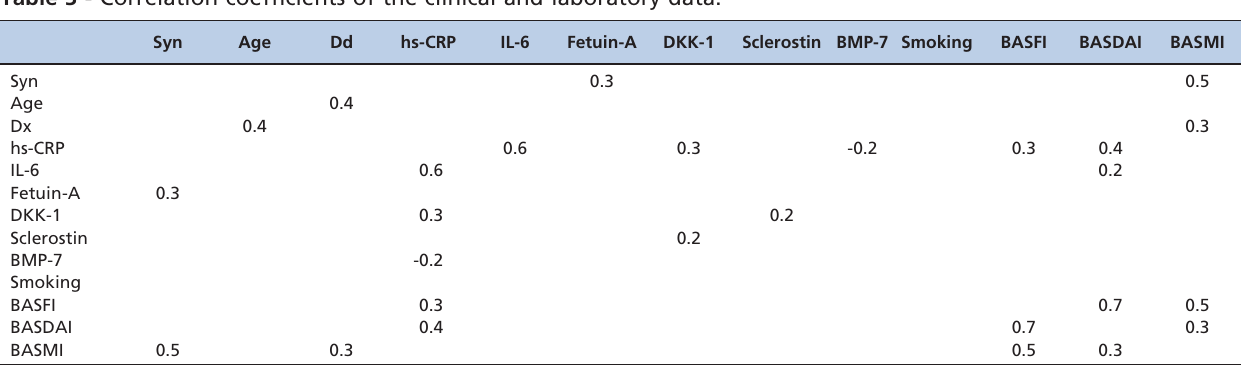
spondylitis functional index, BASDAI: Bath ankylosing spondylitis disease activity index and BASMI: Bath ankylosing spondylitis metrology